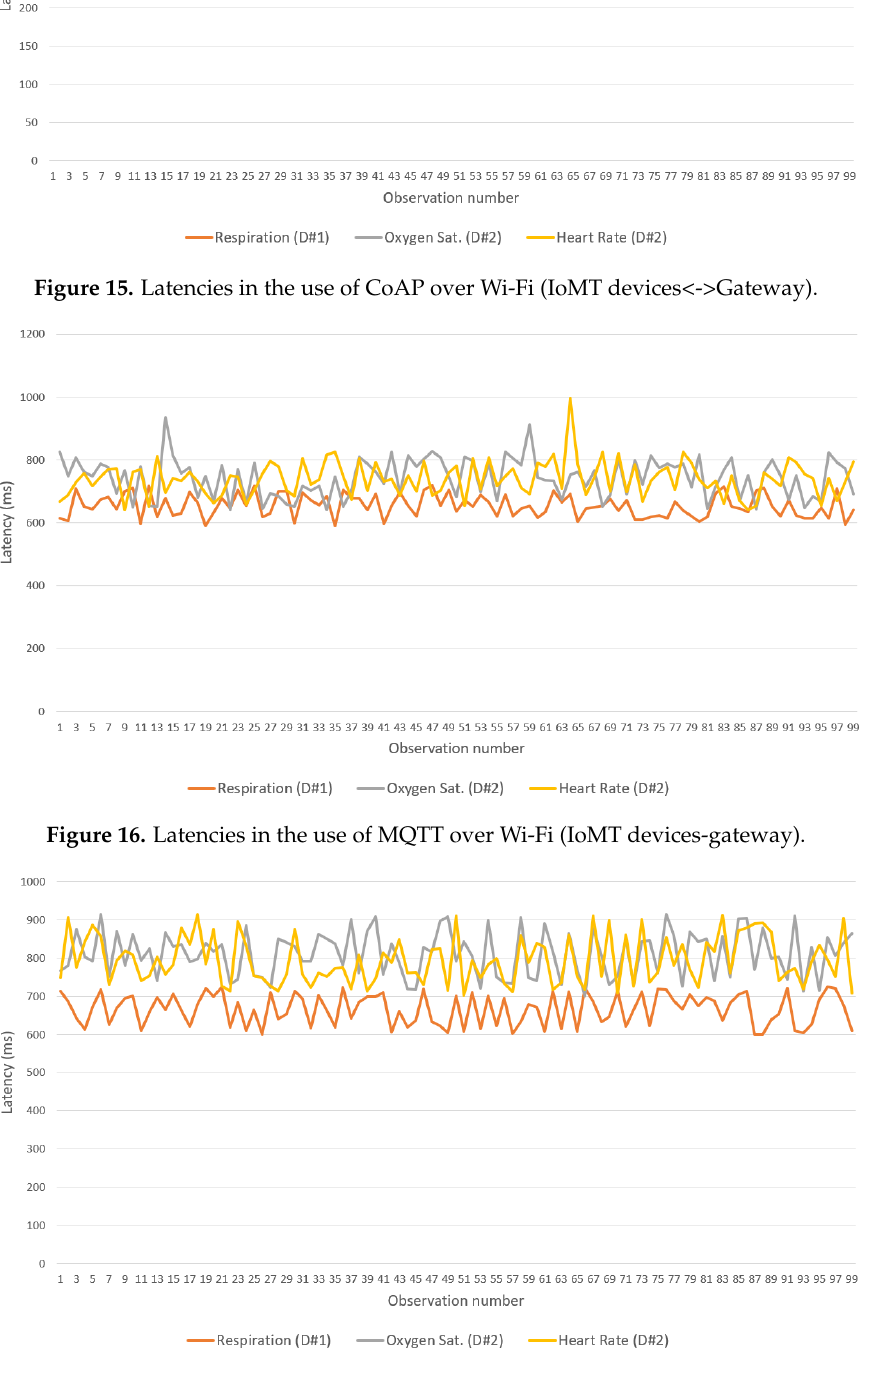
Figure 17. Latencies in the use of REST over Wi-Fi (IoMT